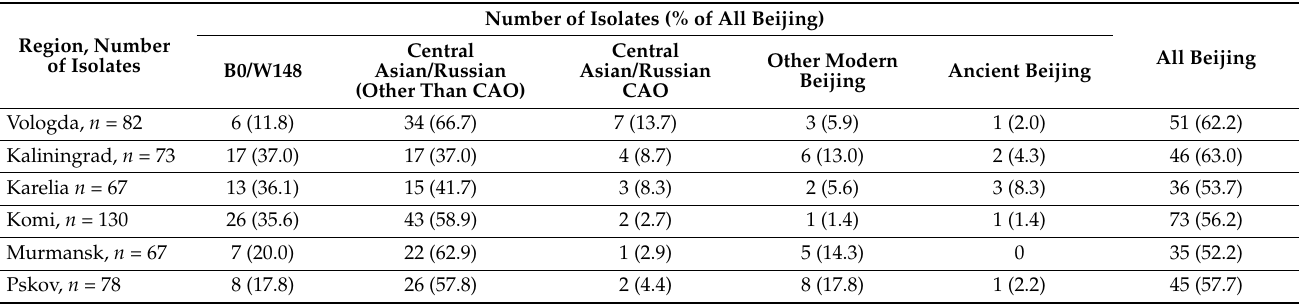
Table 1. M. tuberculosis Beijing genotype subgroups in the regions of Northwestern